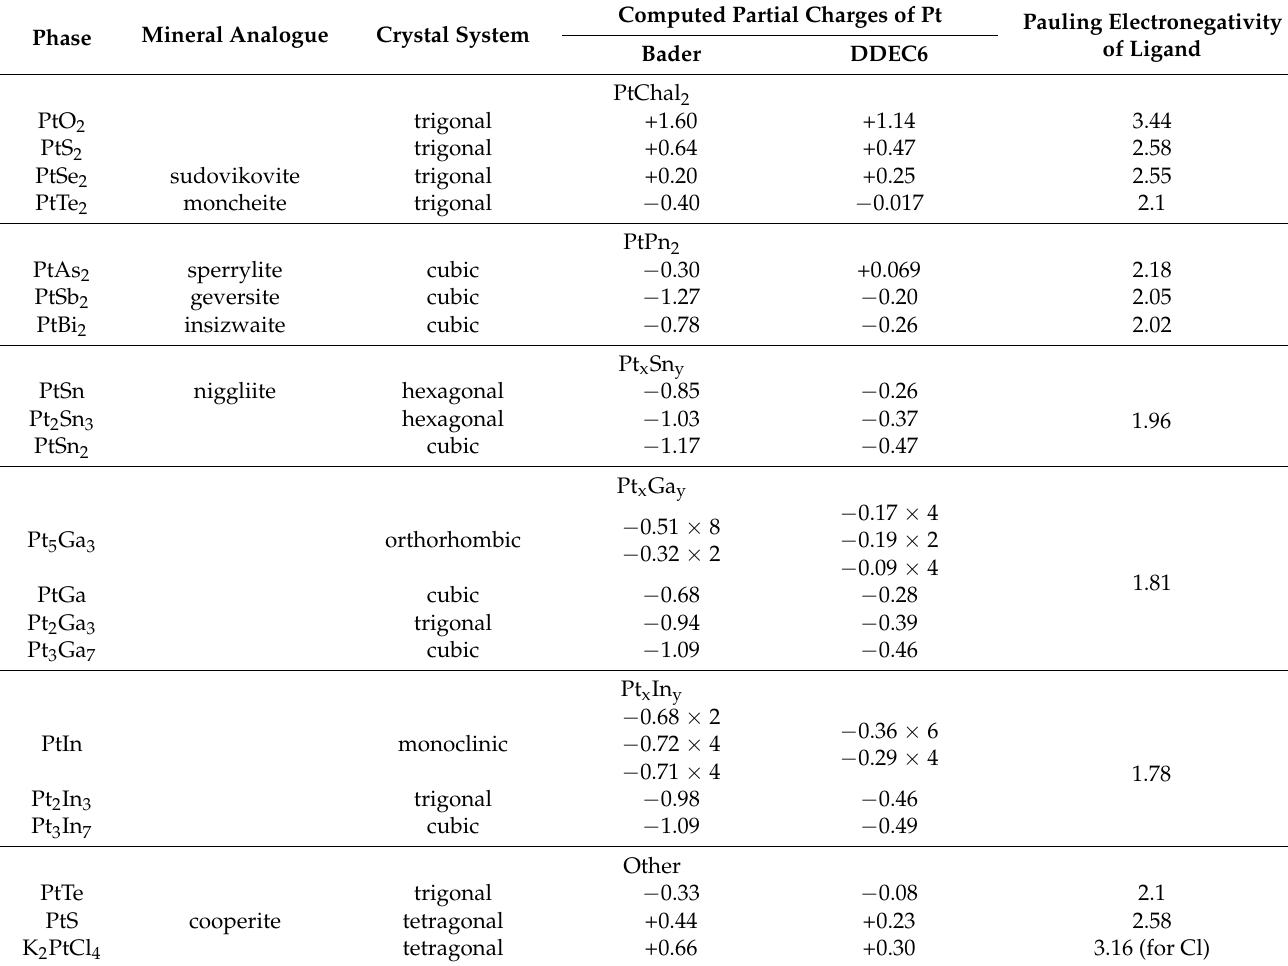
Table 2. Results of DFT calculations of the Pt partial atomic charges (without geometry